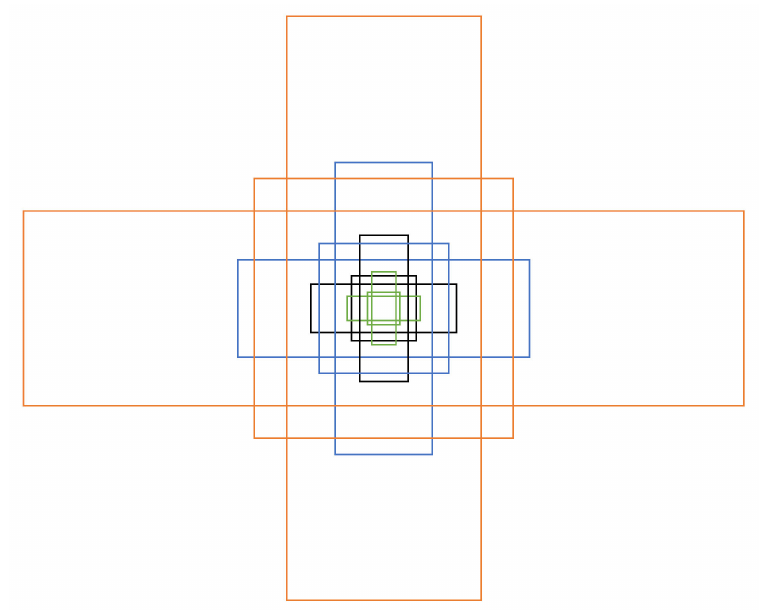
Figure 13. Enhanced anchor box after aspect ratios of 1:3 and